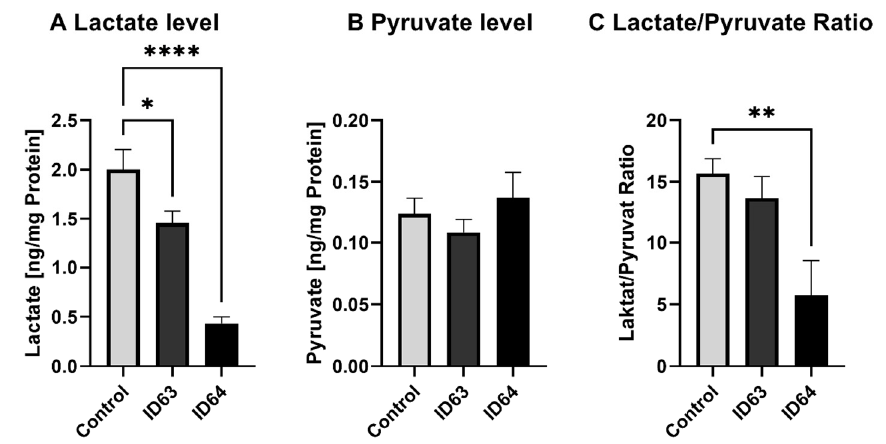
Figure 5. Effect of the incubation with ID63 or ID64 on lactate and pyruvate level after 24 h of incubation. ( A ) Lactate level of SH-SY5Y 695 cells after the incubation with ID63 or ID64 compared to the control. ( B ) Pyruvate level of SH-SY5Y 695 cells after the incubation with ID63 or ID64 compared to the control. ( C ) Lactate to pyruvate ratio. N = 6. Levels were adjusted to the protein content. Significance was determined by one-way ANOVA. * p < 0.05, ** p < 0.01 and **** p < 0.0001. Data are displayed as the mean ± SEM. ID63 = 200 µM MgOr and 10 µM Fol; ID64 = 200 µM MgOr, 10 µM Fol and 100 nM Vit B6.